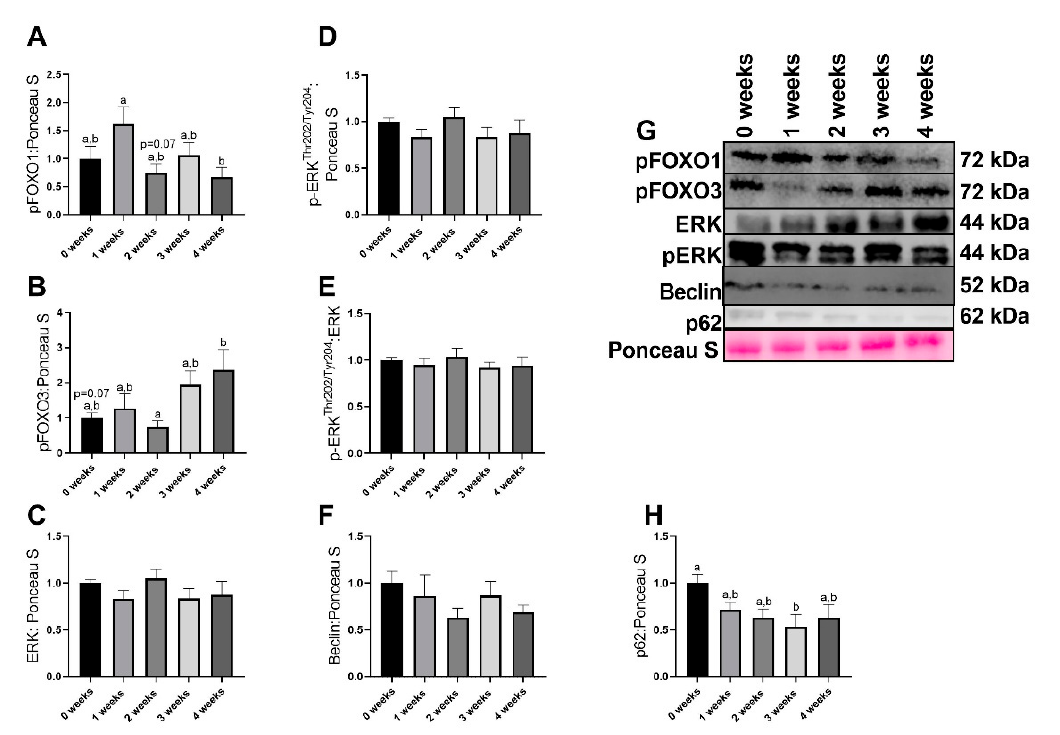
Figure 4. Immunoblot data for moderators of protein anabolism. ( A ) pFOXO1 protein data. ( B ) pFOXO3 protein content. ( C ) ERK protein content. ( D ) pERK Thr202 / Tyr204 . ( E ) pERK Thr202 / Tyr204 / ERK protein content. ( F ) Beclin protein content. ( G ) Representative images for immunoblot data. ( H ) p62 protein data. Data are presented as mean ± SEM. Di ff erent letters represent statistical di ff erences at a Tukey adjusted p < 0.05. n = 8–10 /